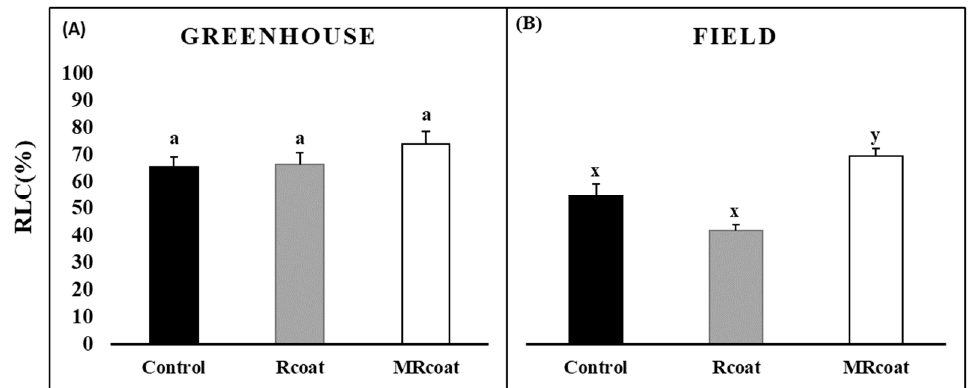
Figure 2. Percentage of root length colonization (% RLC) of chickpea non-inoculated (control) and inoculated with Rhizophagus irregularis BEG140 (Rcoat) or mixture of R. irregularis isolates (MRcoat) via seed coating in greenhouse ( A ) and field ( B ) trials. Columns are means ± 1 SE and letters indicate significant according to Duncan’s Multiple Range test at p < 0.05.